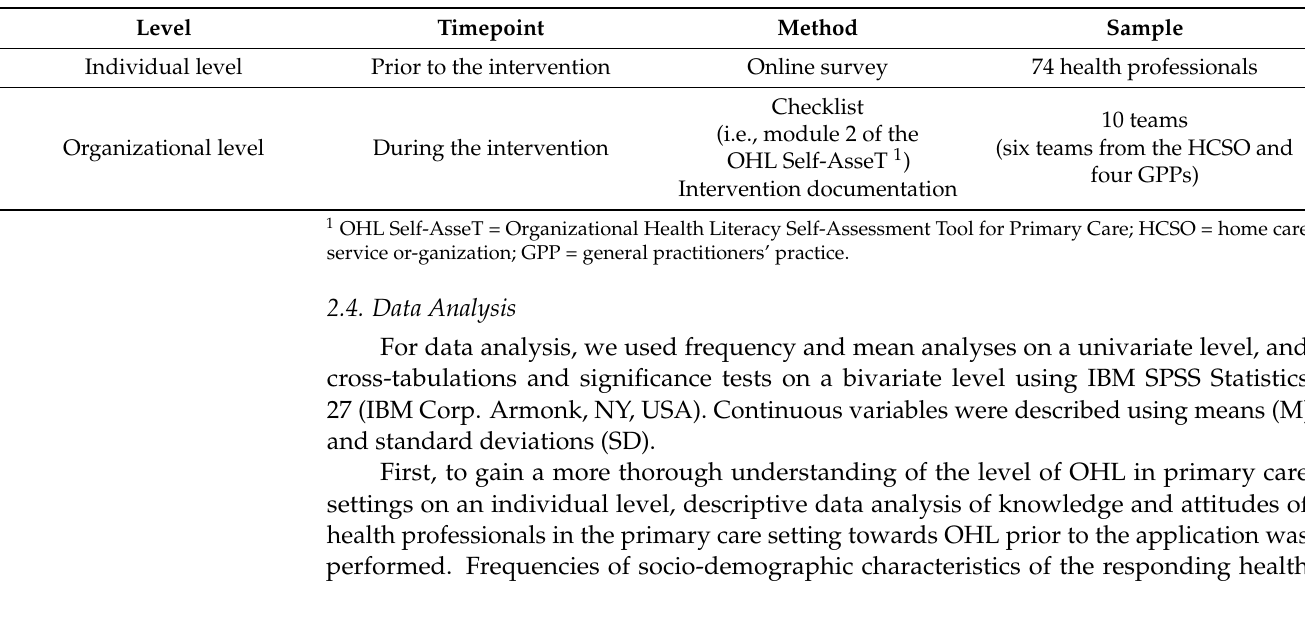
Table 1. Sampling and data